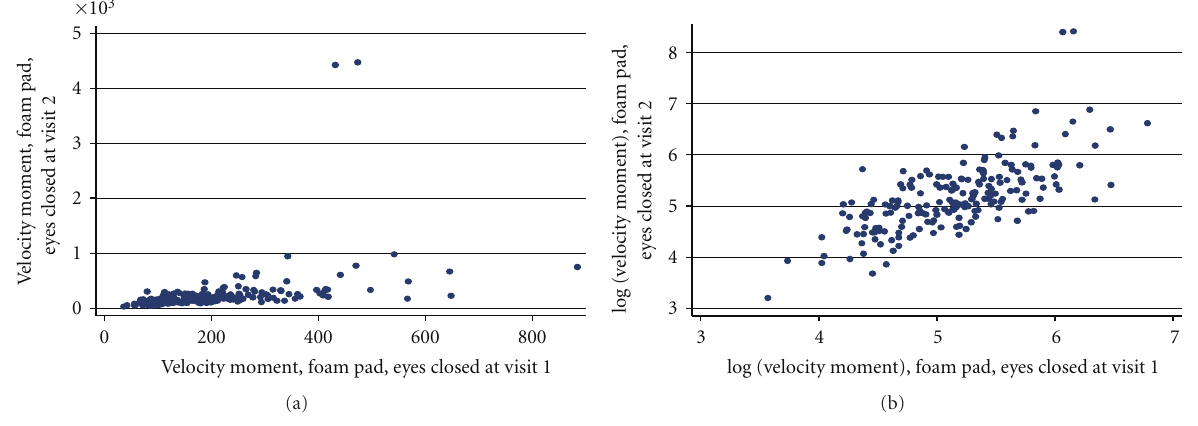
Figure 1: Velocity moment, foam eyes closed, before (a) and after (b) log